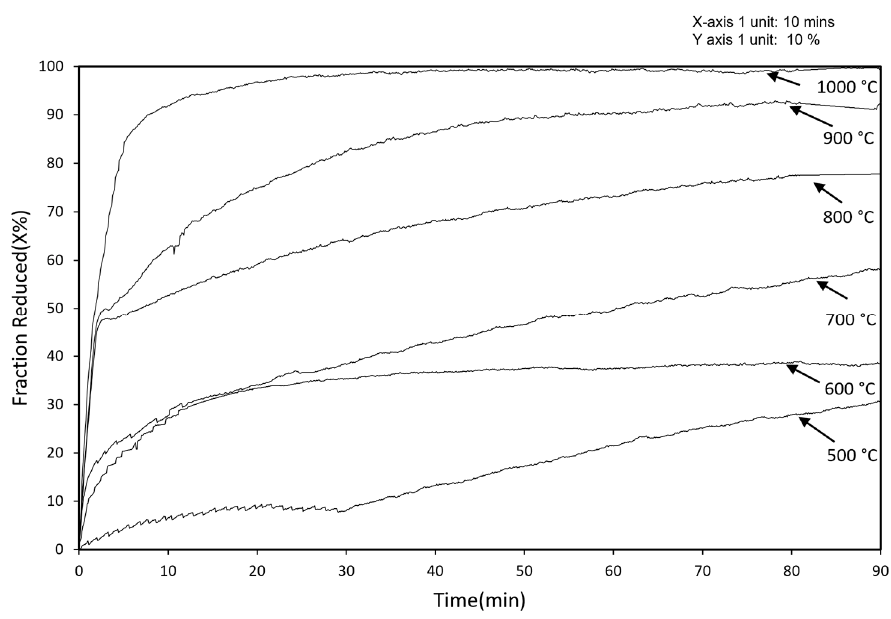
Figure 17. Fraction reduced curves of oxide-sintered pellets with temperature.